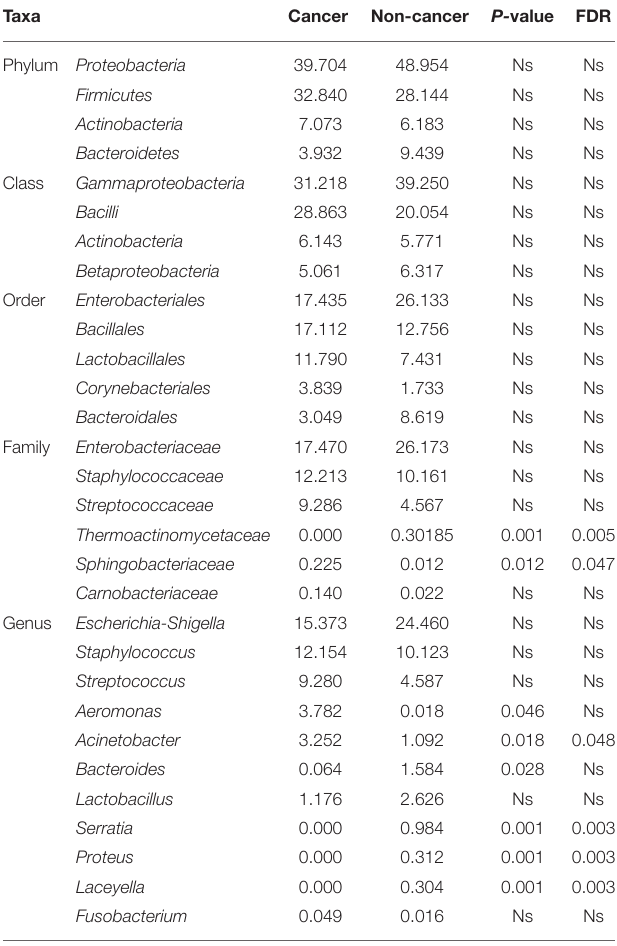
TABLE 2 | Comparison of relative abundance of urinary microbiome between cancer group and control group at all taxonomic